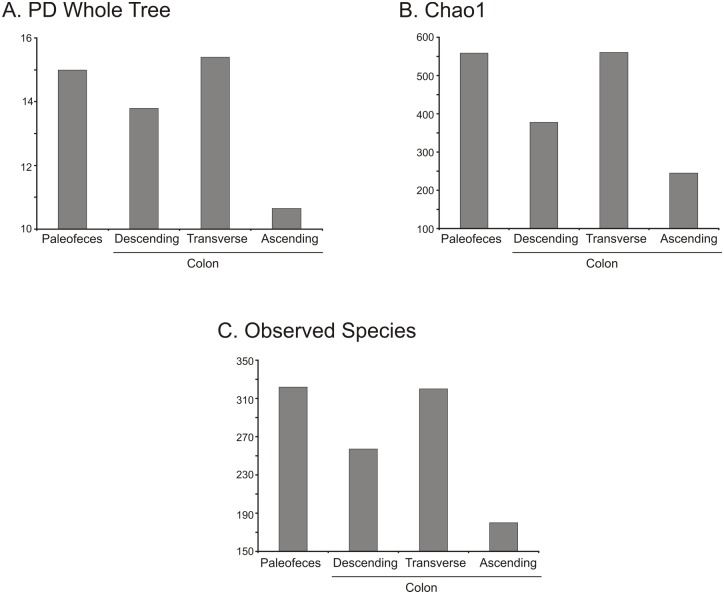
Bar plot representing the PD whole tree (Panel A), chao 1 (Panel B) and observed species (Panel C) indeces for the bacterial taxonomy based on 16S rRNA gene for paleofeces and mummified descending, transverse and ascending colon.